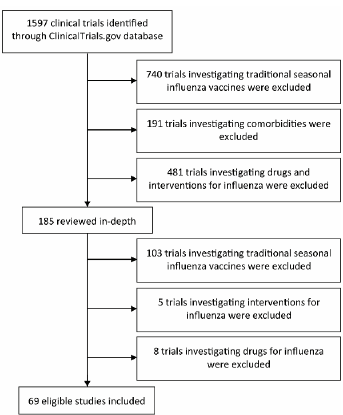
Figure 1. Study selection flow diagram. ClinicalTrials.gov database search resulted in 1597 clinical trials identified. After initial screening, 185 clinical trials were reviewed in depth. A total of 69 eligible universal influenza vaccine clinical trials were included in this review. See Materials and Methods for further information.